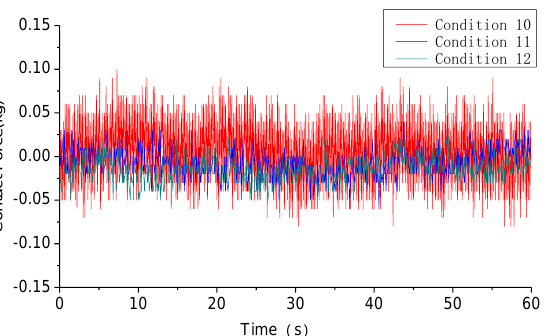
Figure 9. The curve of contact force vs. time considering the draft depth effect.